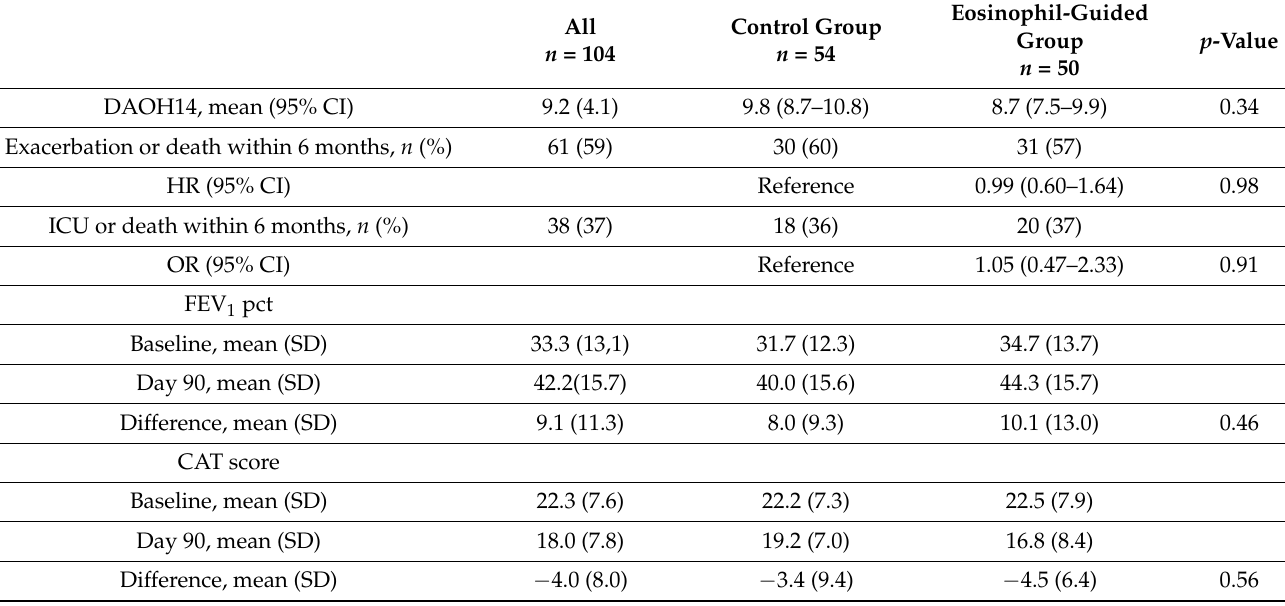
Table 2. Main analysis on current